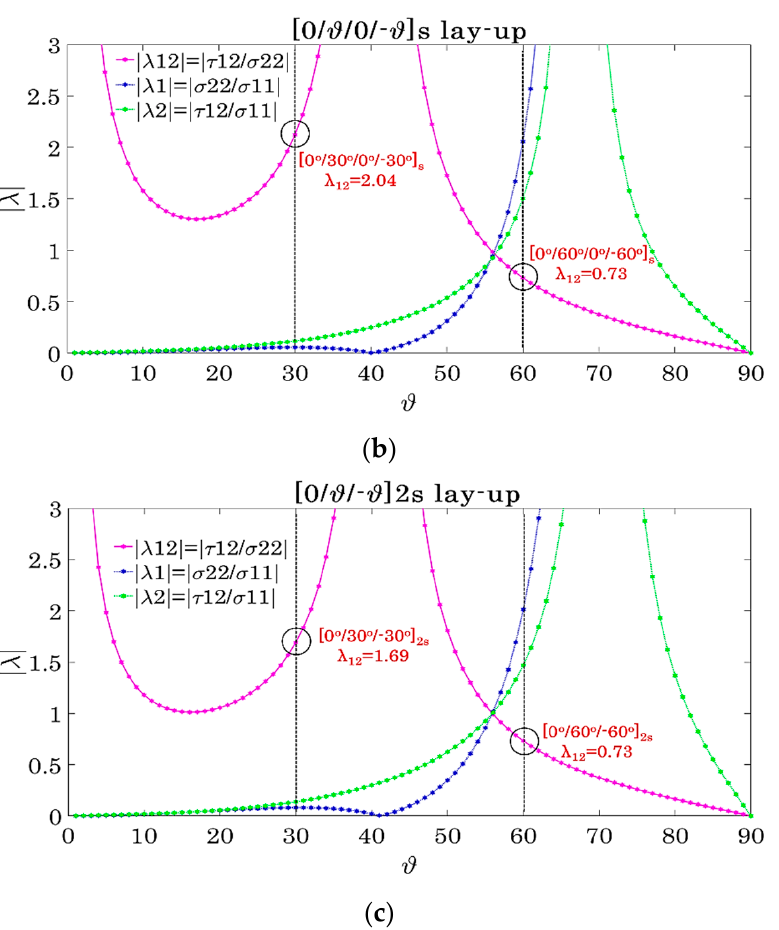
Figure 1. Absolute biaxiality ratios λ in the off-axis layers of ( a ) [0°/ θ ] 2s , ( b ) [0°/ θ /0°/ −θ ] s and ( c ) [0°/ θ / −θ ] 2s laminates versus θ .